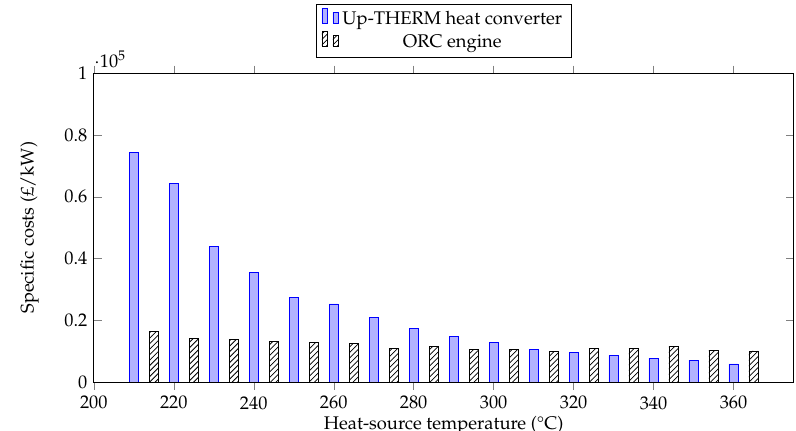
Figure 12. Specific costs for the Up-THERM heat converter and equivalent ORC engines for n -pentane as the working fluid at different heat-source